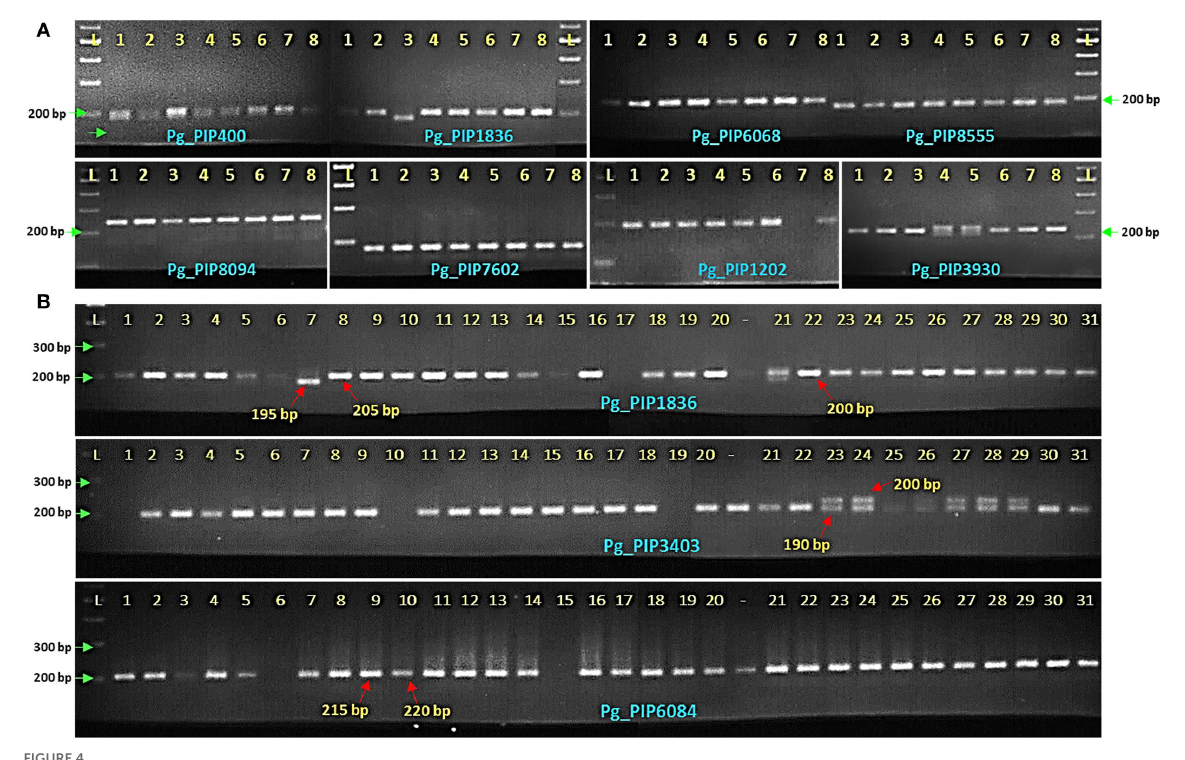
Cluster 1 primarily had 10 wild genotypes, with an out-grouping of 9 cultivars. In addition, the PCA plot also separated 31 genotypes into two major groups (Figure 8B). The principal coordinates (PCos) 1 and 2 explained 19.9% and 10.98% of the total variance, respectively, accounting for 30.88% of the overall variation. Interestingly, PCo 1 distinguished two clusters into the wild and cultivar